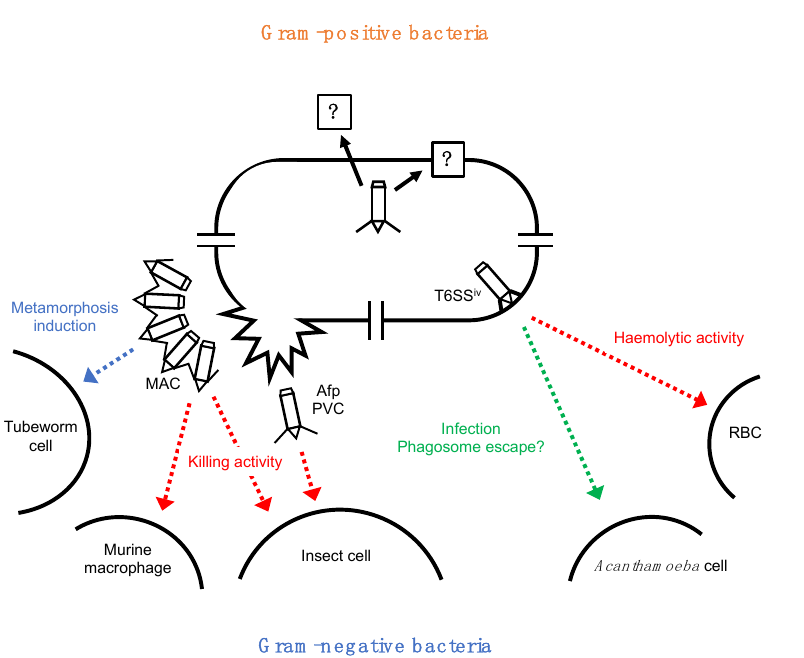
Figure 2. Currently known functions of eCIS: a schematic model of the localisation and biological functions of known eCISs and related nanostructures. MAC, metamorphosis-associated contractile structures. Afp, anti-feeding prophage. PVC, Photorhabdus virulence cassette. RBC, red blood cell.